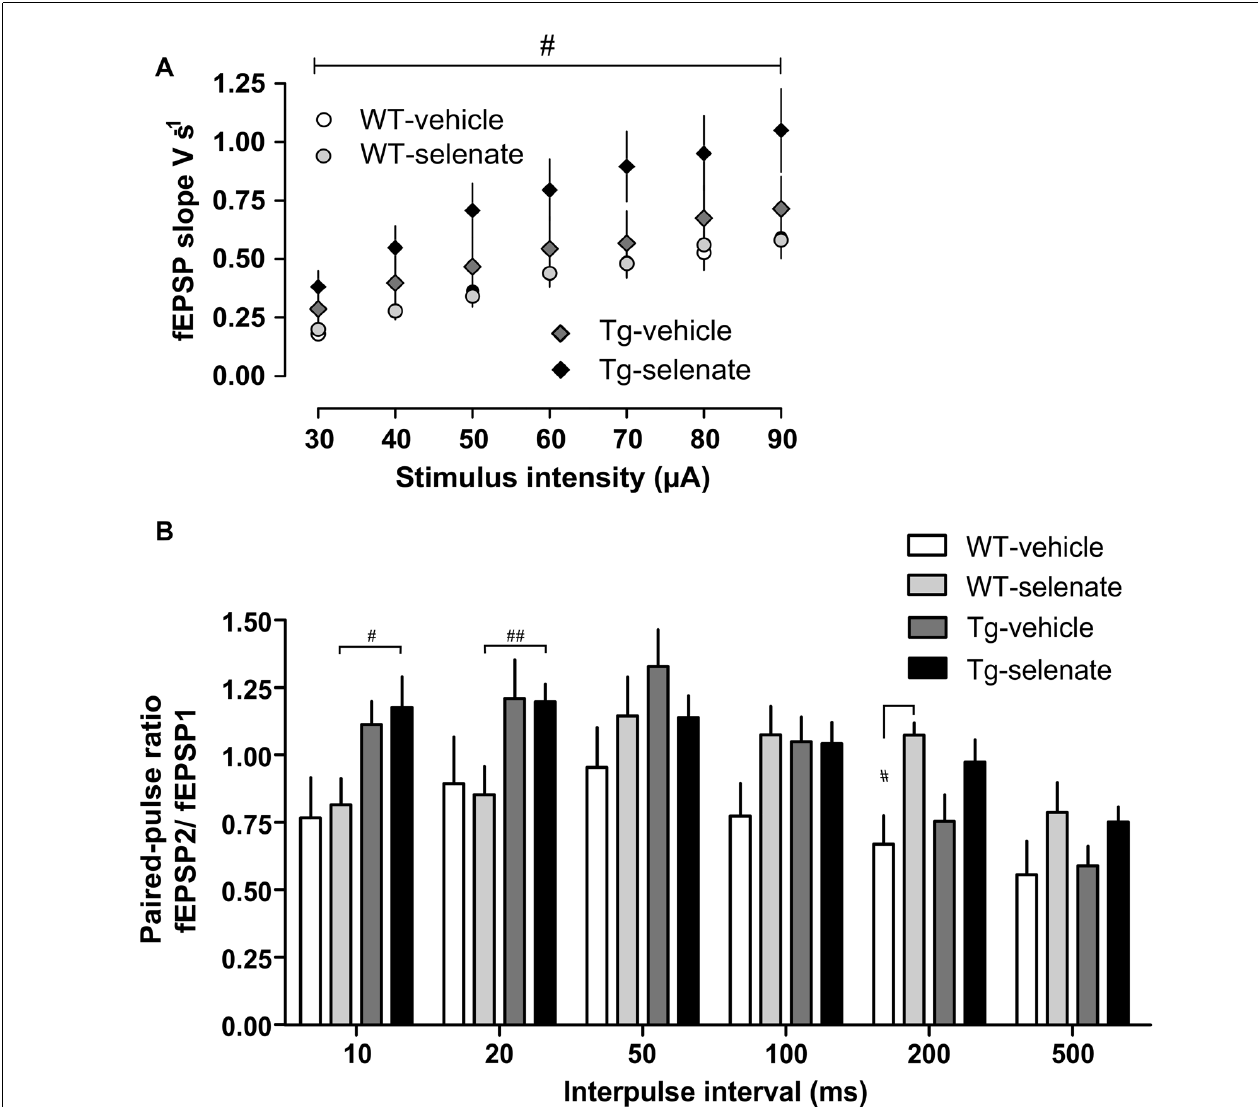
FIGURE 4 | Enhanced basal synaptic transmission by selenate treatment in Tg mice. (A) Chronic selenate application increased basal synaptic transmission in Tg mice. Two-way ANOVA confirmed a significant between-group difference ( F (3,35) = 3.389, p < 0.029) and post hoc comparisons revealed a significant enhancement of synaptic transmission in selenate-treated Tg mice ( n = 10) compared to selenate-treated WT mice ( n = 8; p ≤ 0.020, Dunnett test with WT-sel as the control group). (B) Selenate-treated Tg mice ( n = 12) had higher paired-pulse values than selenate-treated WT mice ( n = 12) at short interpulse intervals of 10 and 20 ms. Interestingly, selenate caused a significant enhancement of paired-pulse values in WT mice at 200 ms. Two-Way ANOVA plus Dunnett post hoc test compared with WT-selenate. Mean ± SEM is given. Bar with # indicates significance level ≤ 0.05 of Dunnett post hoc test, likewise # p ≤ 0.05; ## p ≤ 0.01.